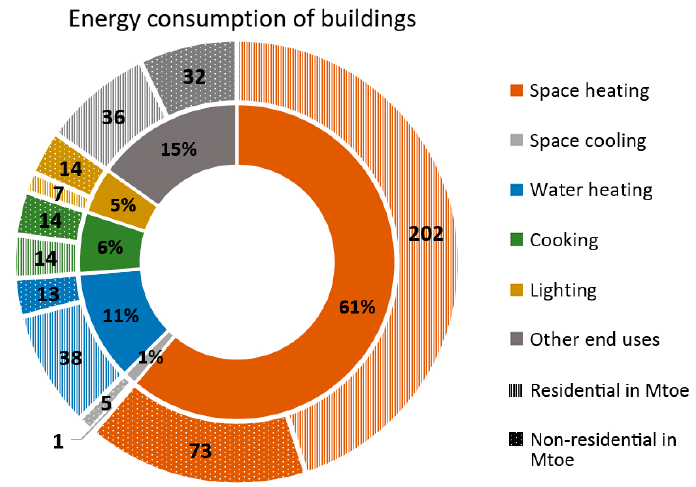
Figure 8. Final energy consumption in buildings for EU28 in 2013. Data according to [230].